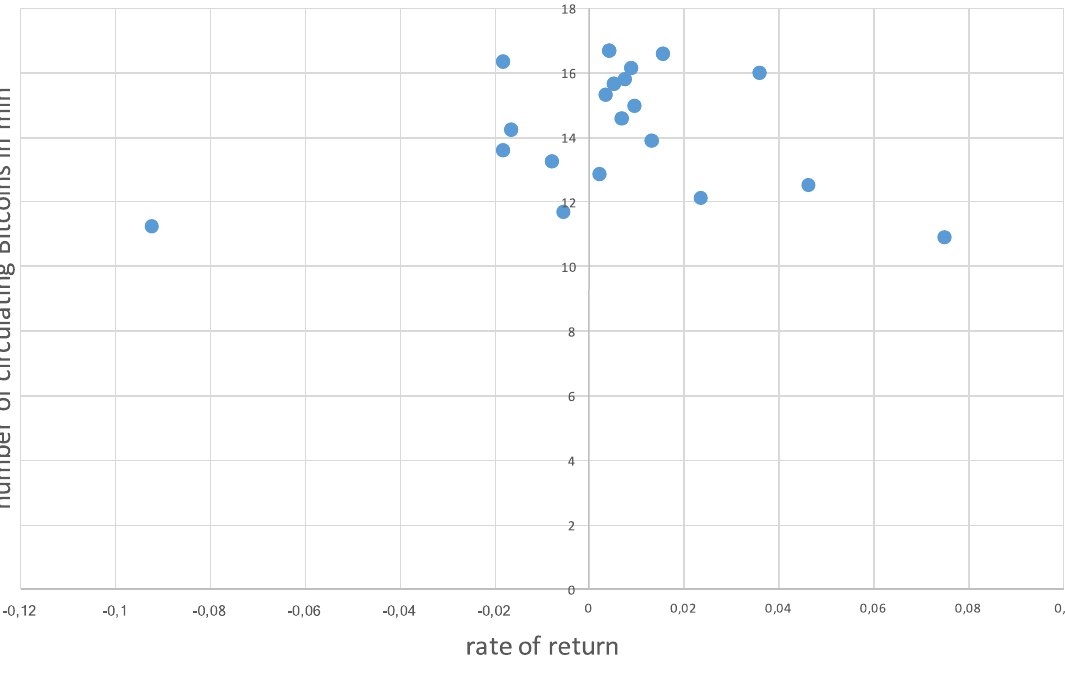
Figure 6. Correlation of the rate of return from Bitcoin in relation to the number of Bitcoins in circulation for the Bitfinex Stock Exchange (million,